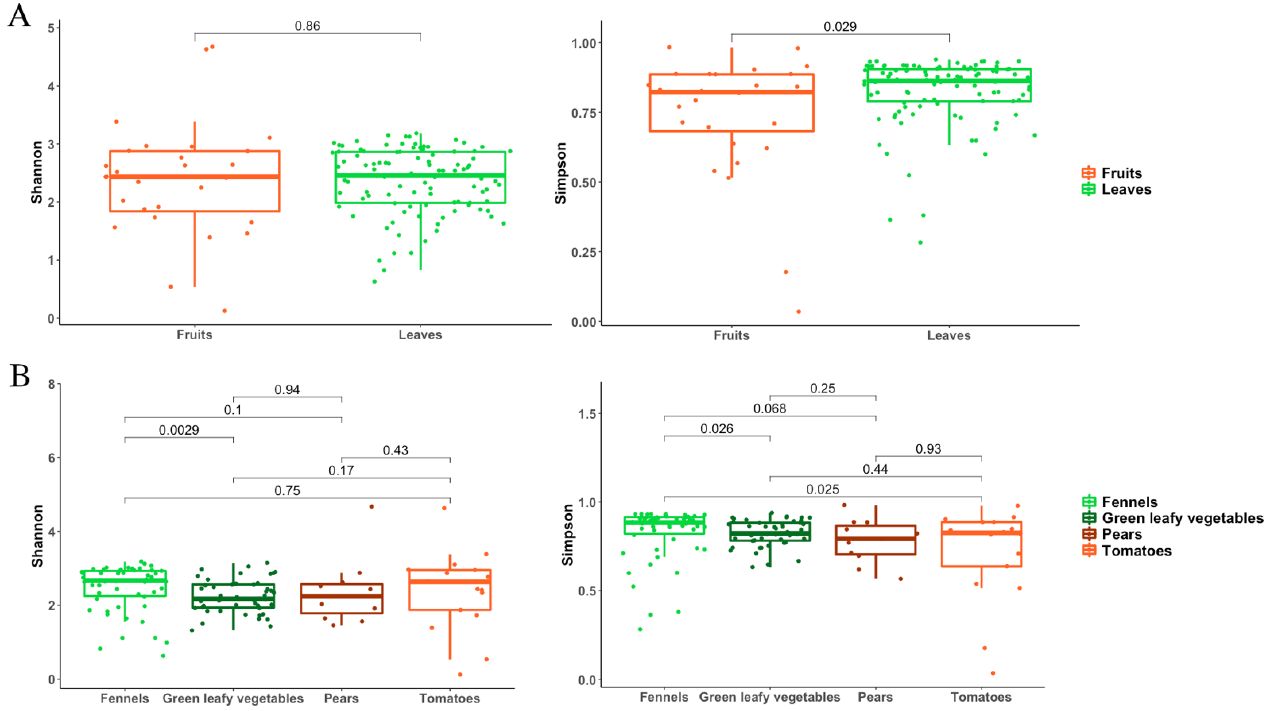
Figure 4. Bacterial alpha diversity indices compared between ( A ) fruits and leaves and ( B ) the four types of